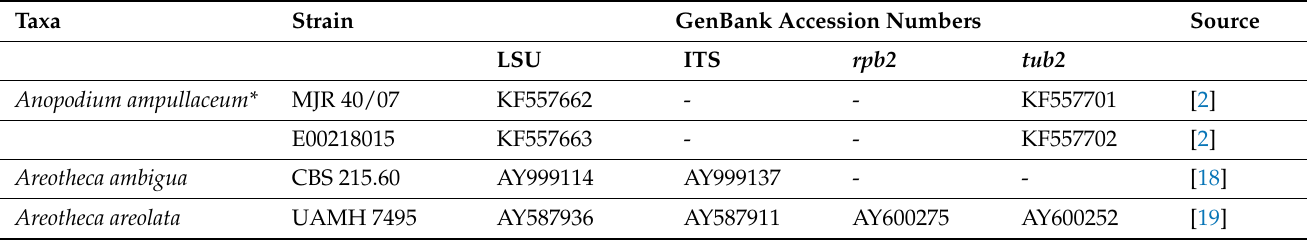
Table 1. Strains of the order Sordariales included in the phylogenetic study. Taxonomic novelties are indicated in bold italic. Taxa Strain GenBank Accession